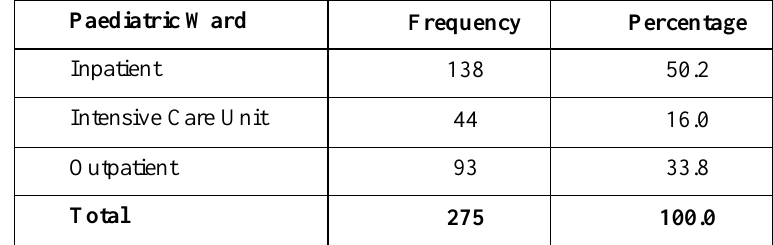
Table 1. Studied patients visiting or admitted to the Fatima Hospital, Karachi.